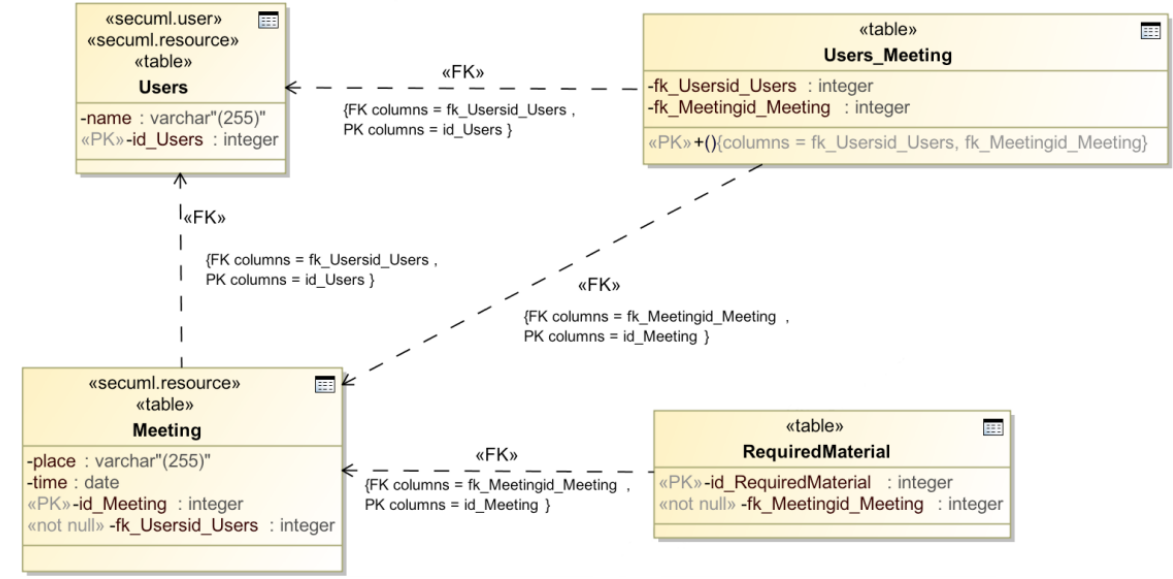
Figure 8. Physical Data Model